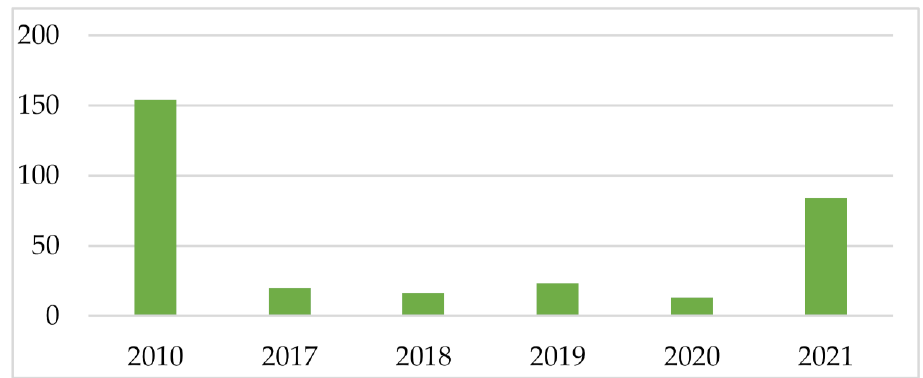
Figure 1. Meteorological data based on NMS (precipitation (mm) in the 30 days before the vegetation